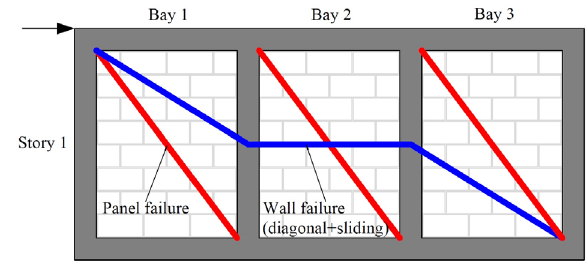
Figure 2. Panel failure and wall